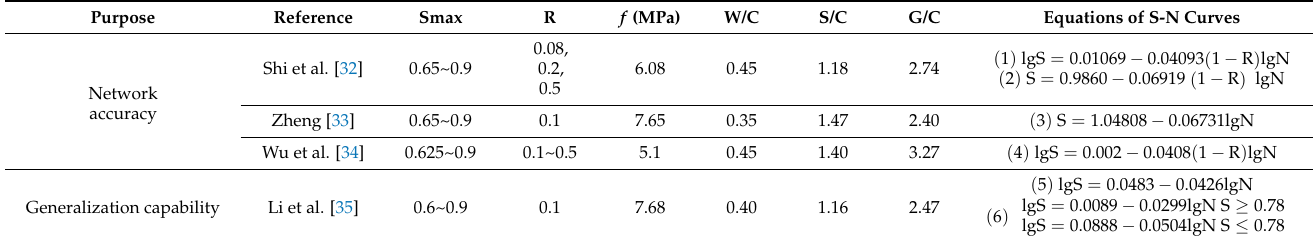
Table 1. Flexural fatigue experimental data.